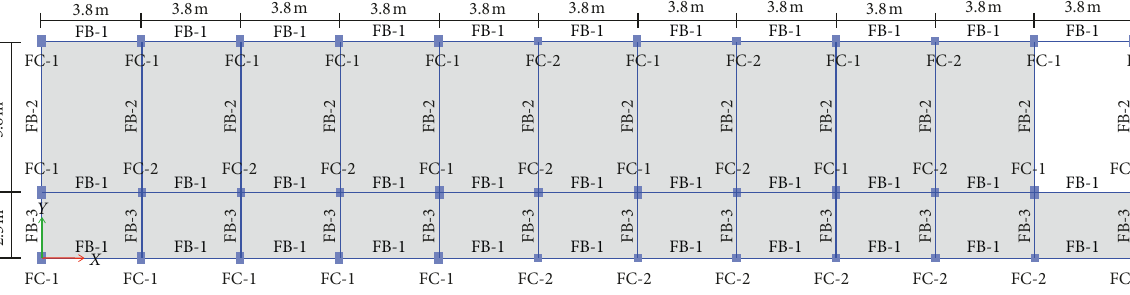
Figure 4: Plan view of the considered building typology.